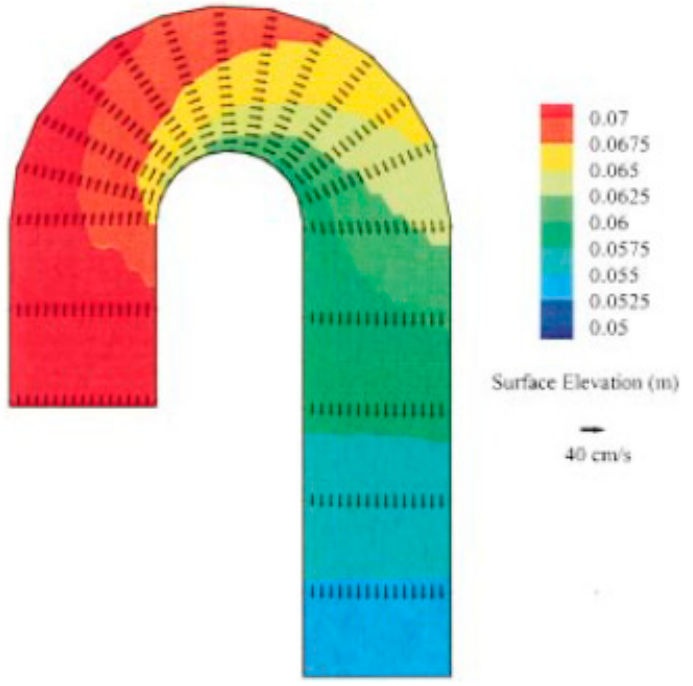
Figure 7. Surface elevation and velocity distribution (Reproduced from Duan (2004) [50] with permission from ASCE).